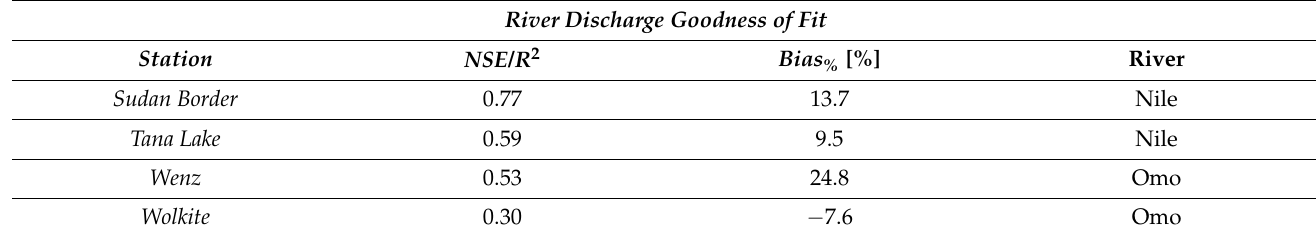
Table 6. Goodness of fit of Poli-Hydro model. Monthly statistics as available.